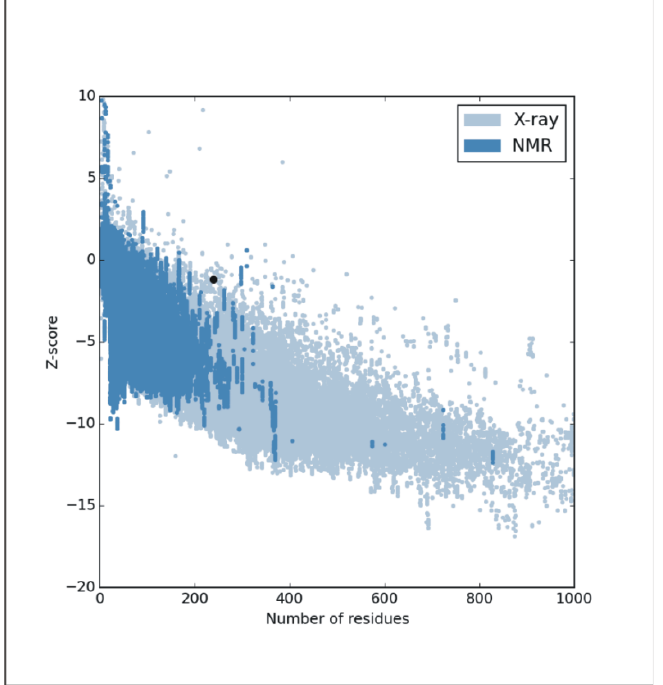
Figure 3. Z ‐ score plot showing the model quality in X ‐ ray region that presents a good quality Figure 3. Z-score plot showing the model quality in X-ray region that presents a good quality model. model.